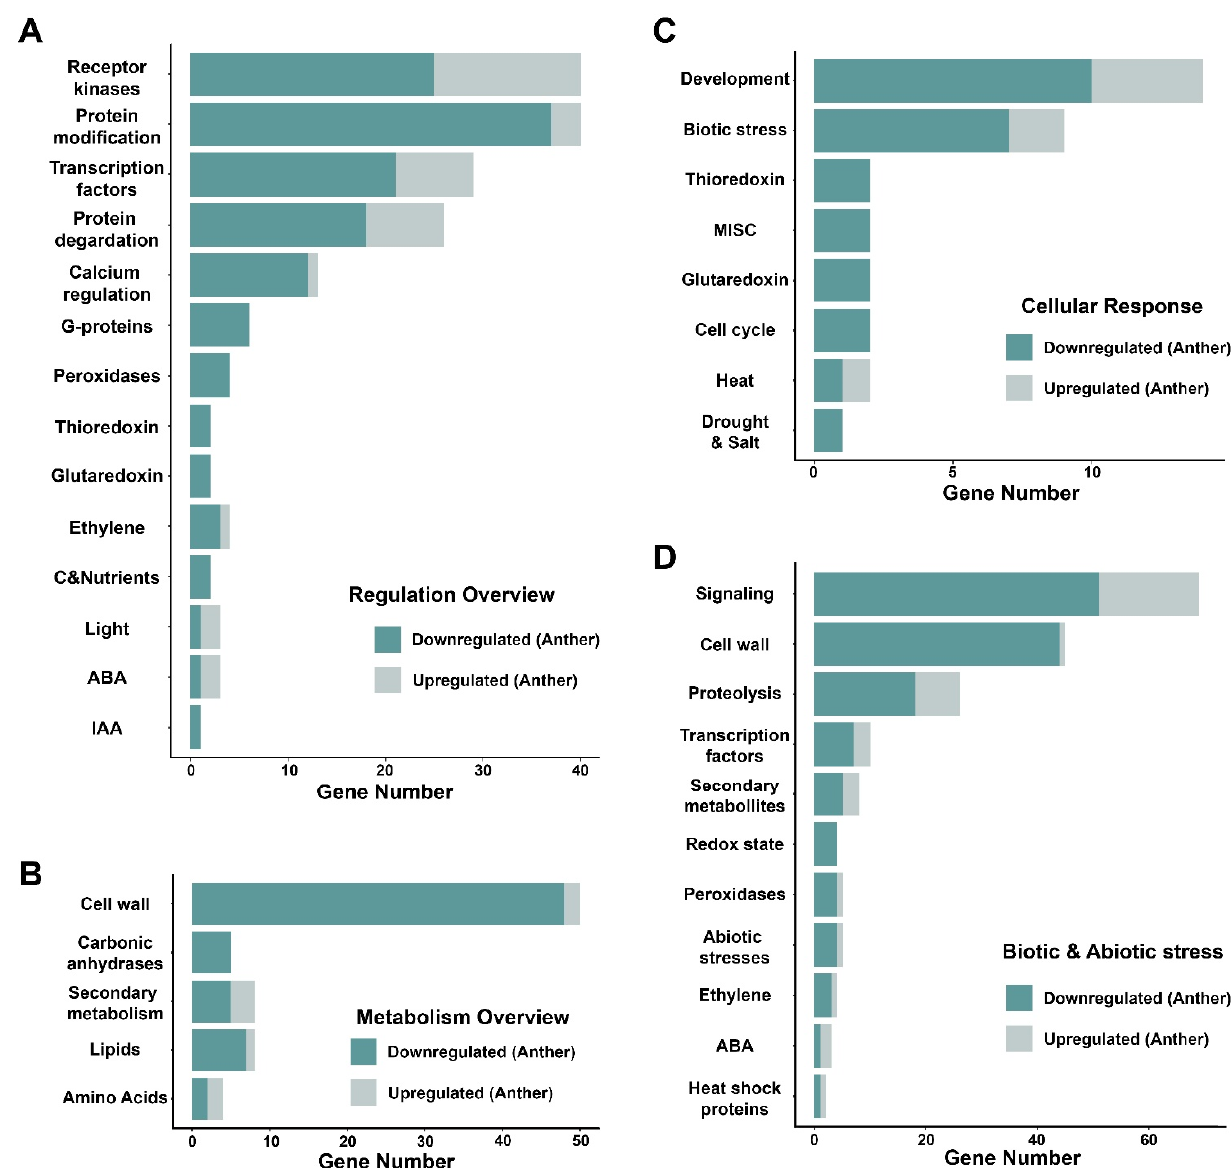
Figure 3. MapMan analysis of DEGs in anther. Each graph is the degree of enrichment for the MapMan pathway. ( A ) is the regulation overview, ( B ) is the metabolism overview, ( C ) is the cellular response, and ( D ) is the biotic and abiotic stress among the MapMan pathway. The x-axis represents the gene number, and the y-axis represents the molecular function registered in MapMan. Dark green indicates the anther downregulated genes, and light green is the anther upregulated